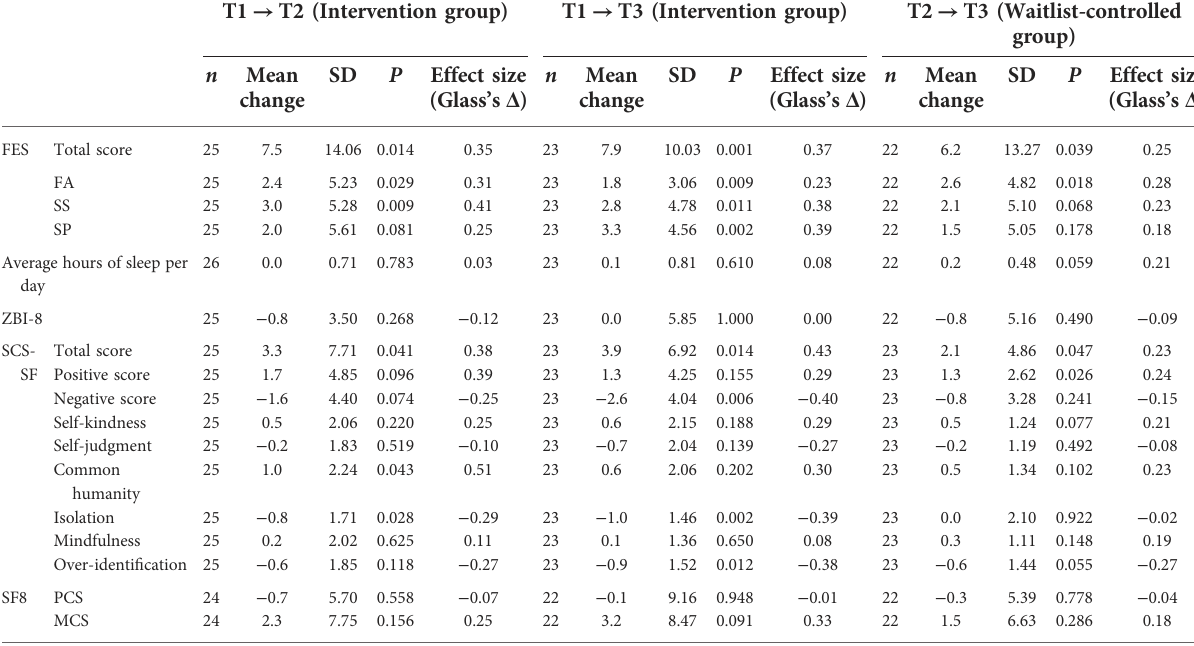
TABLE 4 Maintenance of the intervention effects in the early intervention group and reproducibility of the effect in the delayed (waitlist) group. T1 → T2 (Intervention